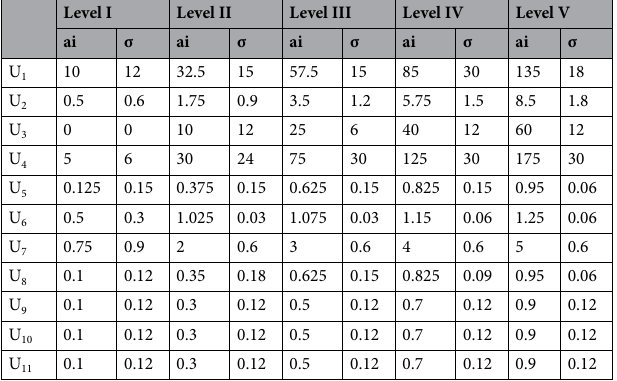
Table 11. Normal distribution